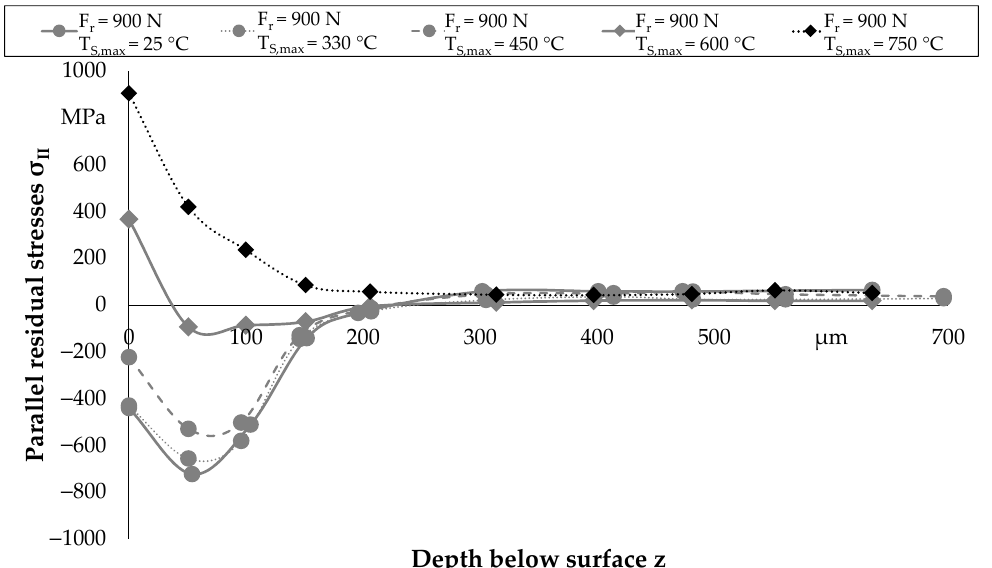
Figure 4. residual stress depth distribution parallel to the rolling direction for T S,max = 25 °C, 330 °C, 450 °C, 600 °C and 750 °C with the deep rolling force F r = 900 N.